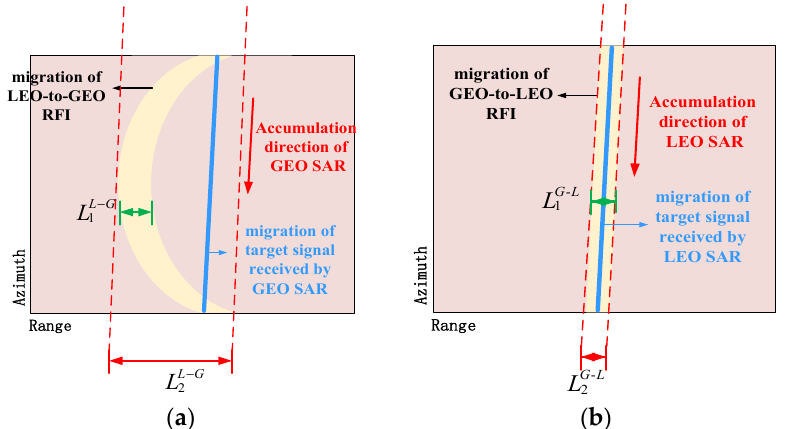
Figure 4. Relationship between migration and the accumulation direction. L 1 is the range direc- tion length of the interference band before the BP algorithms (after the range compression). L 2 is the range direction length of the interference band after the BP algorithms. ( a ) LEO-to-GEO RFI ( b ) GEO-to-LEO